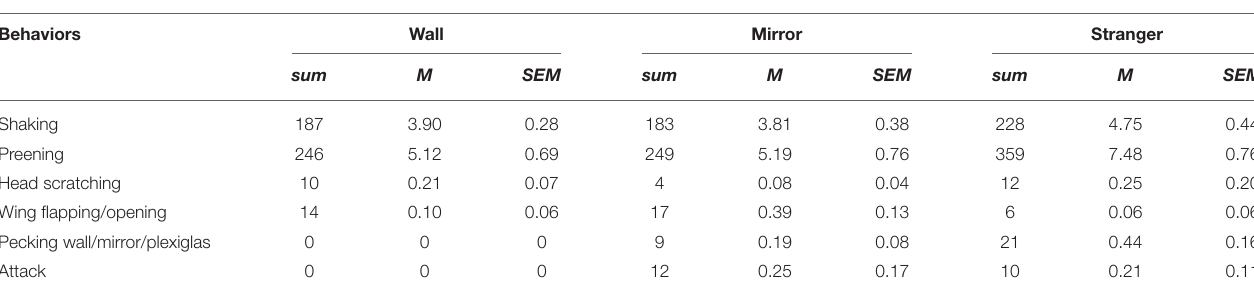
TABLE 1 | Total and mean number of observed